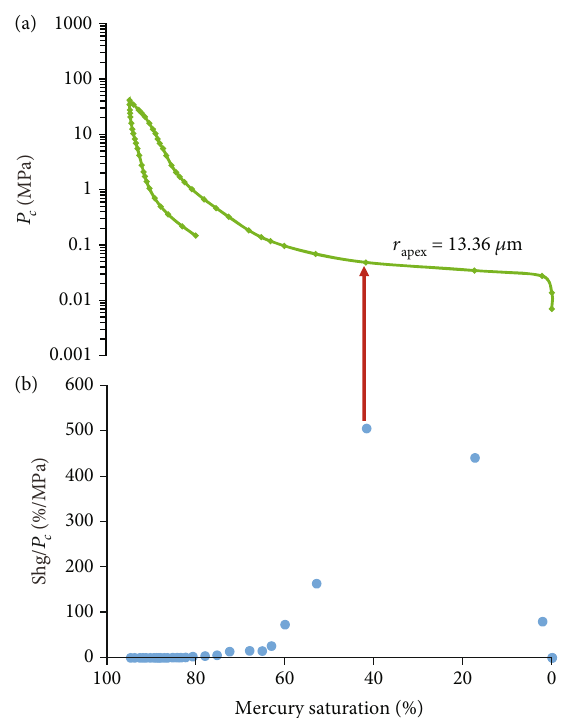
Figure 6: (a) Capillary pressure curve of the Khasib rock sample of the H oil fi eld (H11, 2609.12m, RT1). (b) Pittman ’ s hyperbola shows an